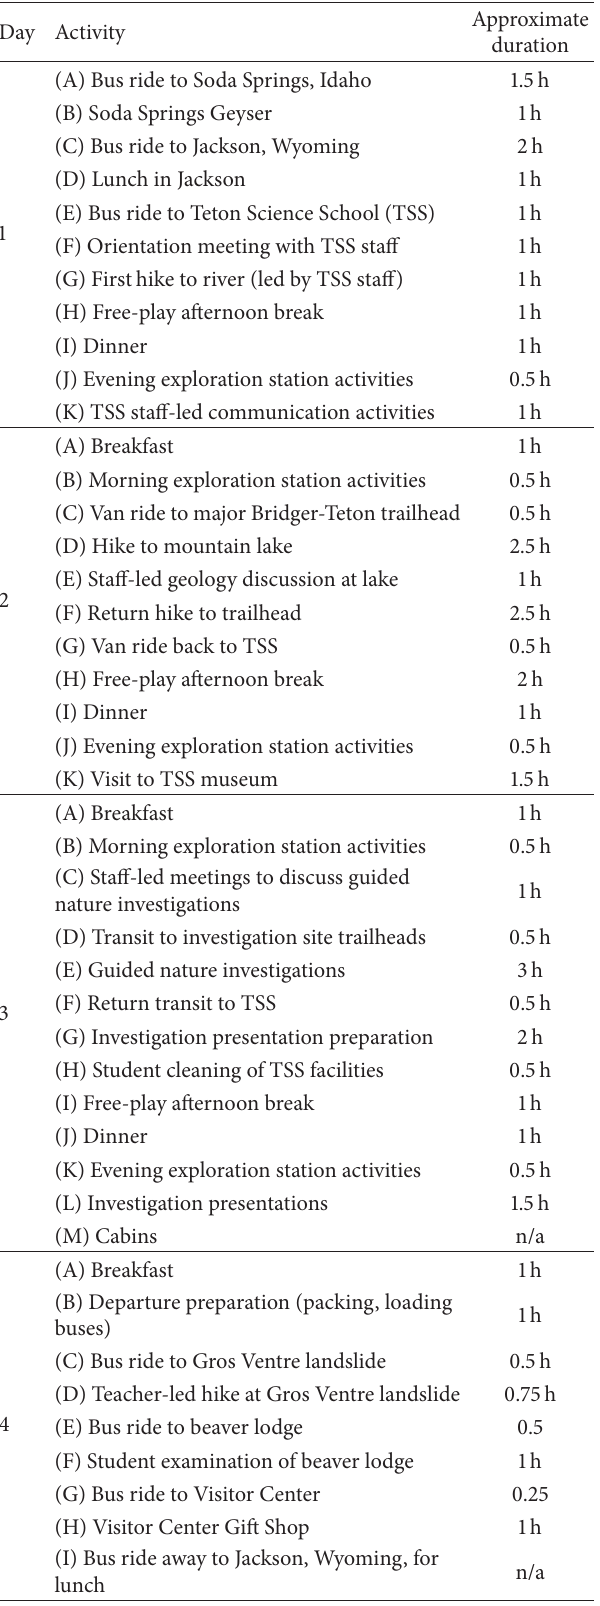
Table 1: Sequence of activities when students had possession of digital